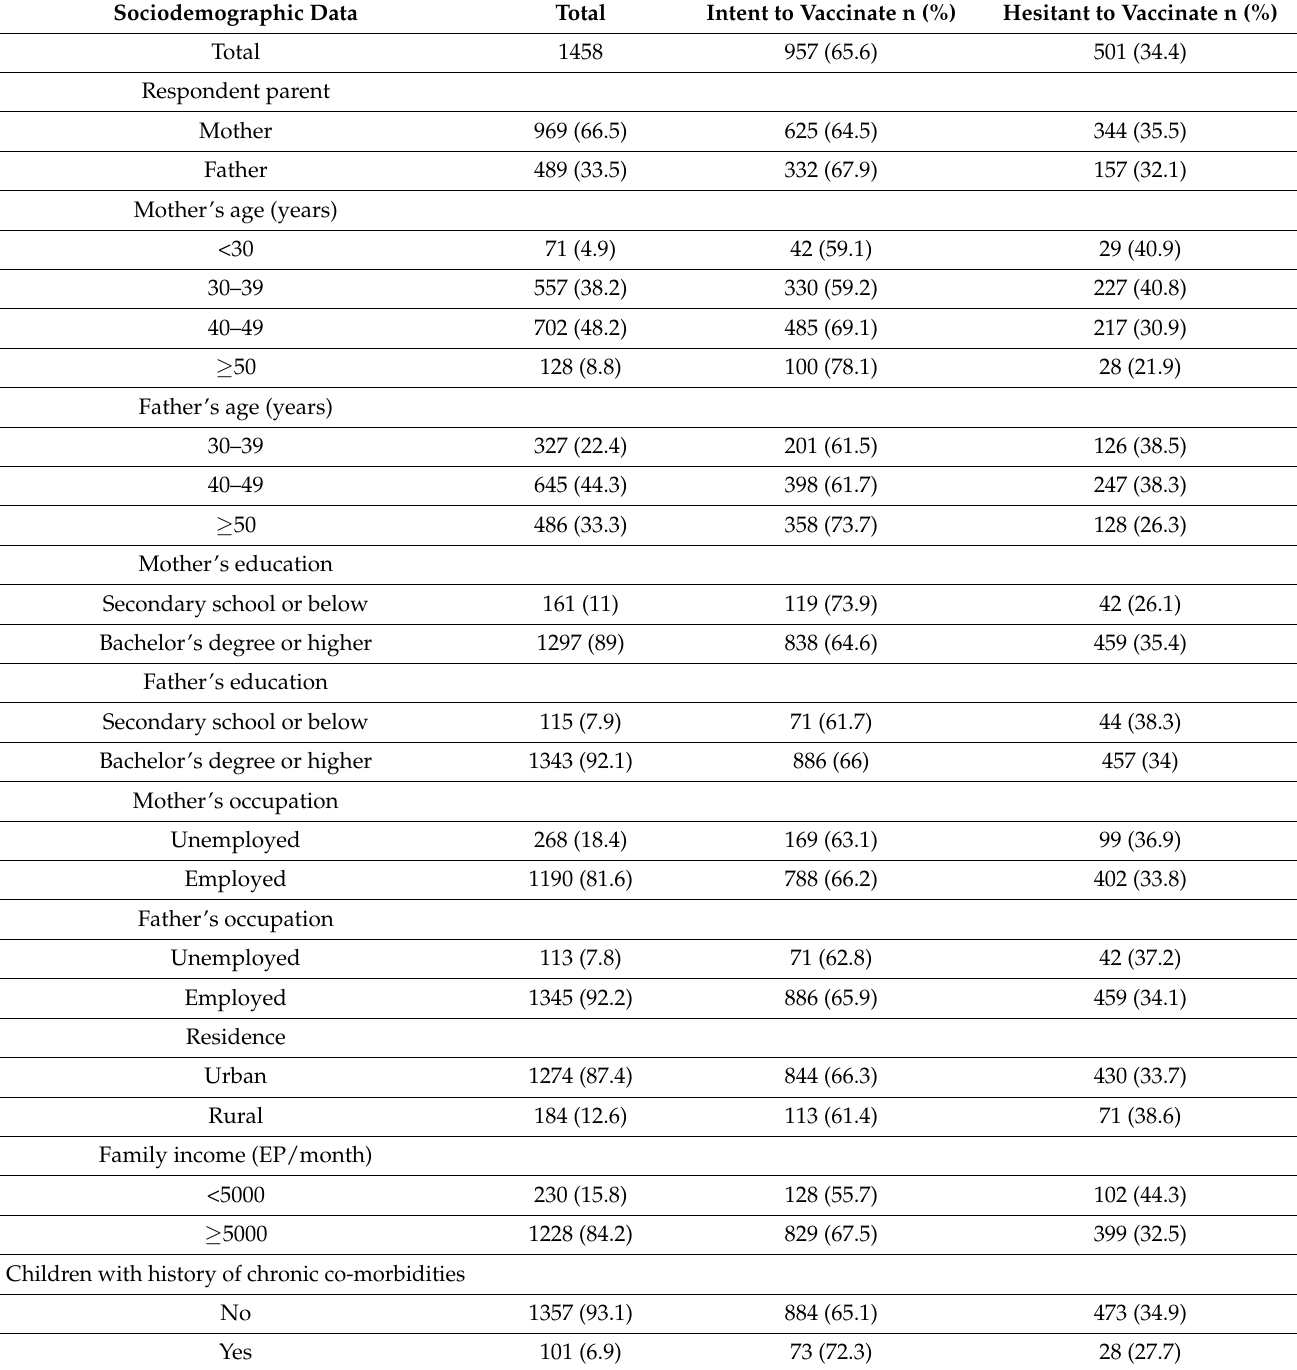
Table 1. Sociodemographic data of the study participants according to their intention to vaccinate their